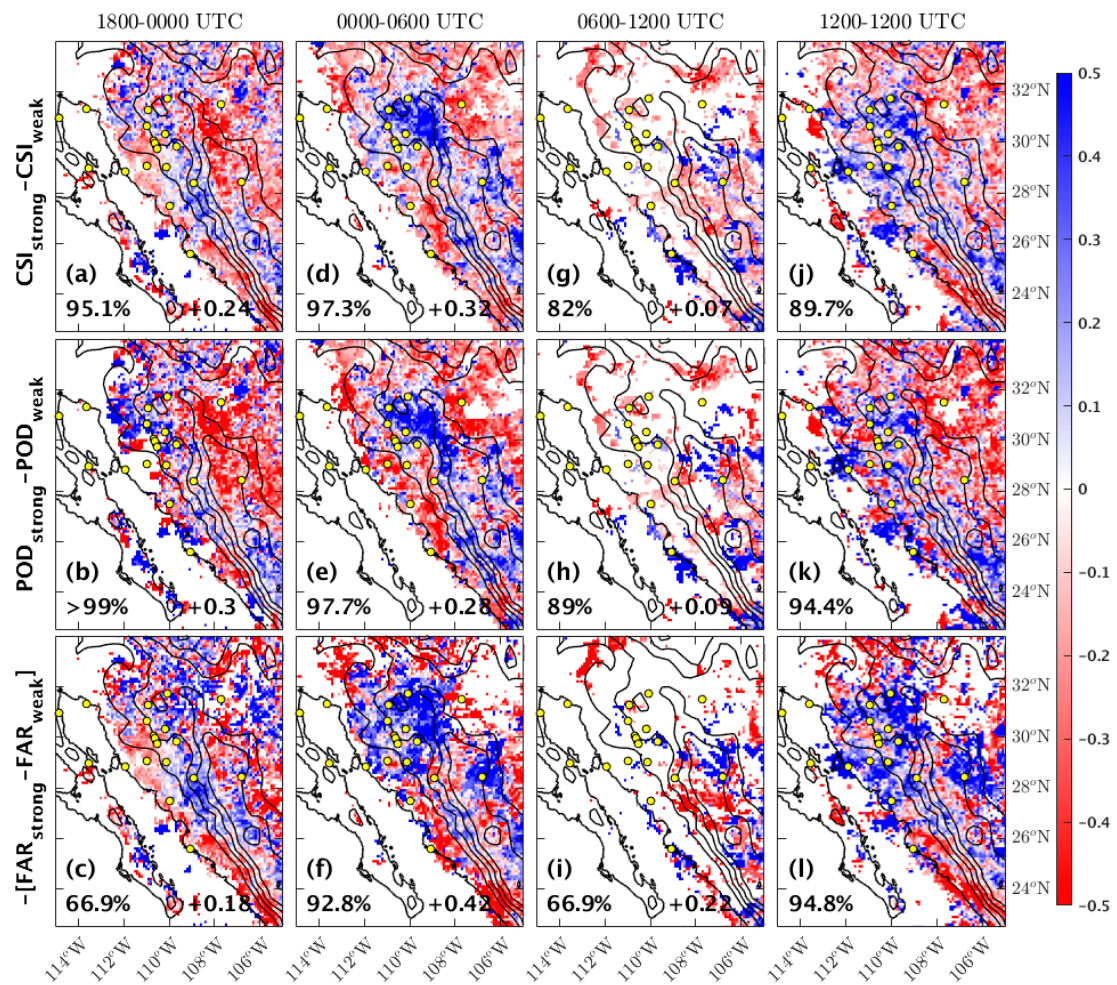
Figure 8. These are the CSI ( a, d, g, j ), POD ( b, e, h, k ), and FAR ( c, f, i, l ) metric differences between strongly and weakly forced days for the WRF-NAM simulations for the 1800–0000 UTC ( a , b , c